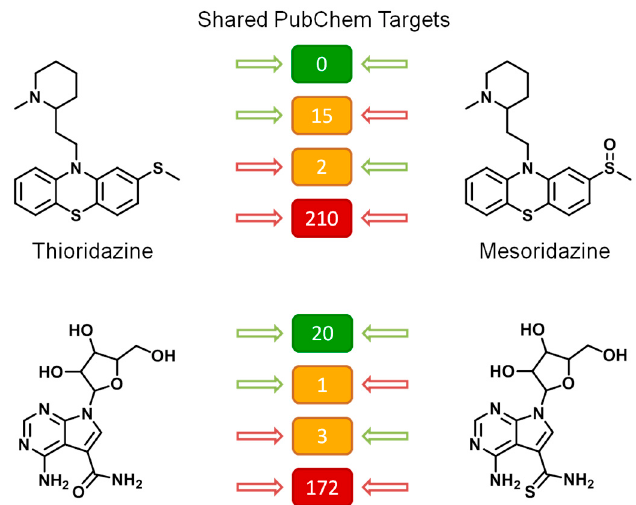
Figure 6. Exemplary MTL analogs. For two MTLs (left), exemplary structural analogs are shown (right). In the center, the number of shared PubChem targets is reported against which both compounds were active (green) and inactive (red) or against which only one or the other compound was active (orange, with green/red arrows).